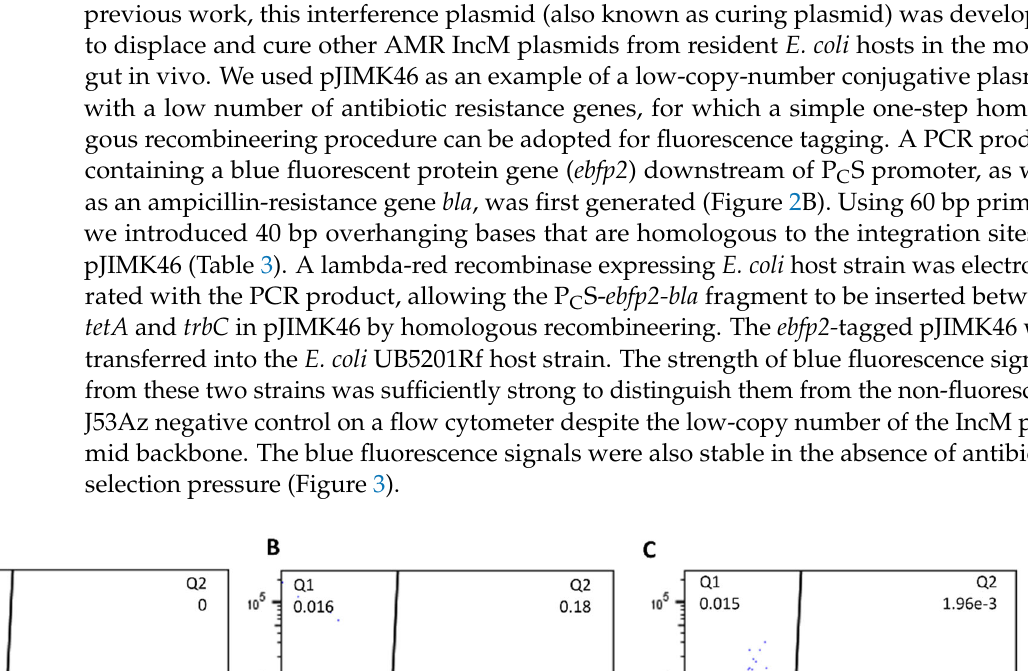
Figure 3. Flow cytometry detection of the E. coli UB5201Rf + pConj_blue ‐ strong donor strain displayed on bivariate plots of red (mCherry) versus blue fluorescence with spectral compensation. Compared to the non ‐ fluorescent J53Az double ‐ negative control strain ( A ), the UB5201Rf + pConj_blue ‐ strong single ‐ color, positive control strain recovered from filter mating incubation conditions at time points 0 h ( B ) and 6 h ( C ) emitted strong blue fluorescence signals that distinguished them very clearly from the negative control. Regions Q1 and Q4 on the red (mCherry2) versus blue (BFP) fluorescence bivariate plots were defined as ebfp2 + and ebfp2 ‐ populations, respectively.